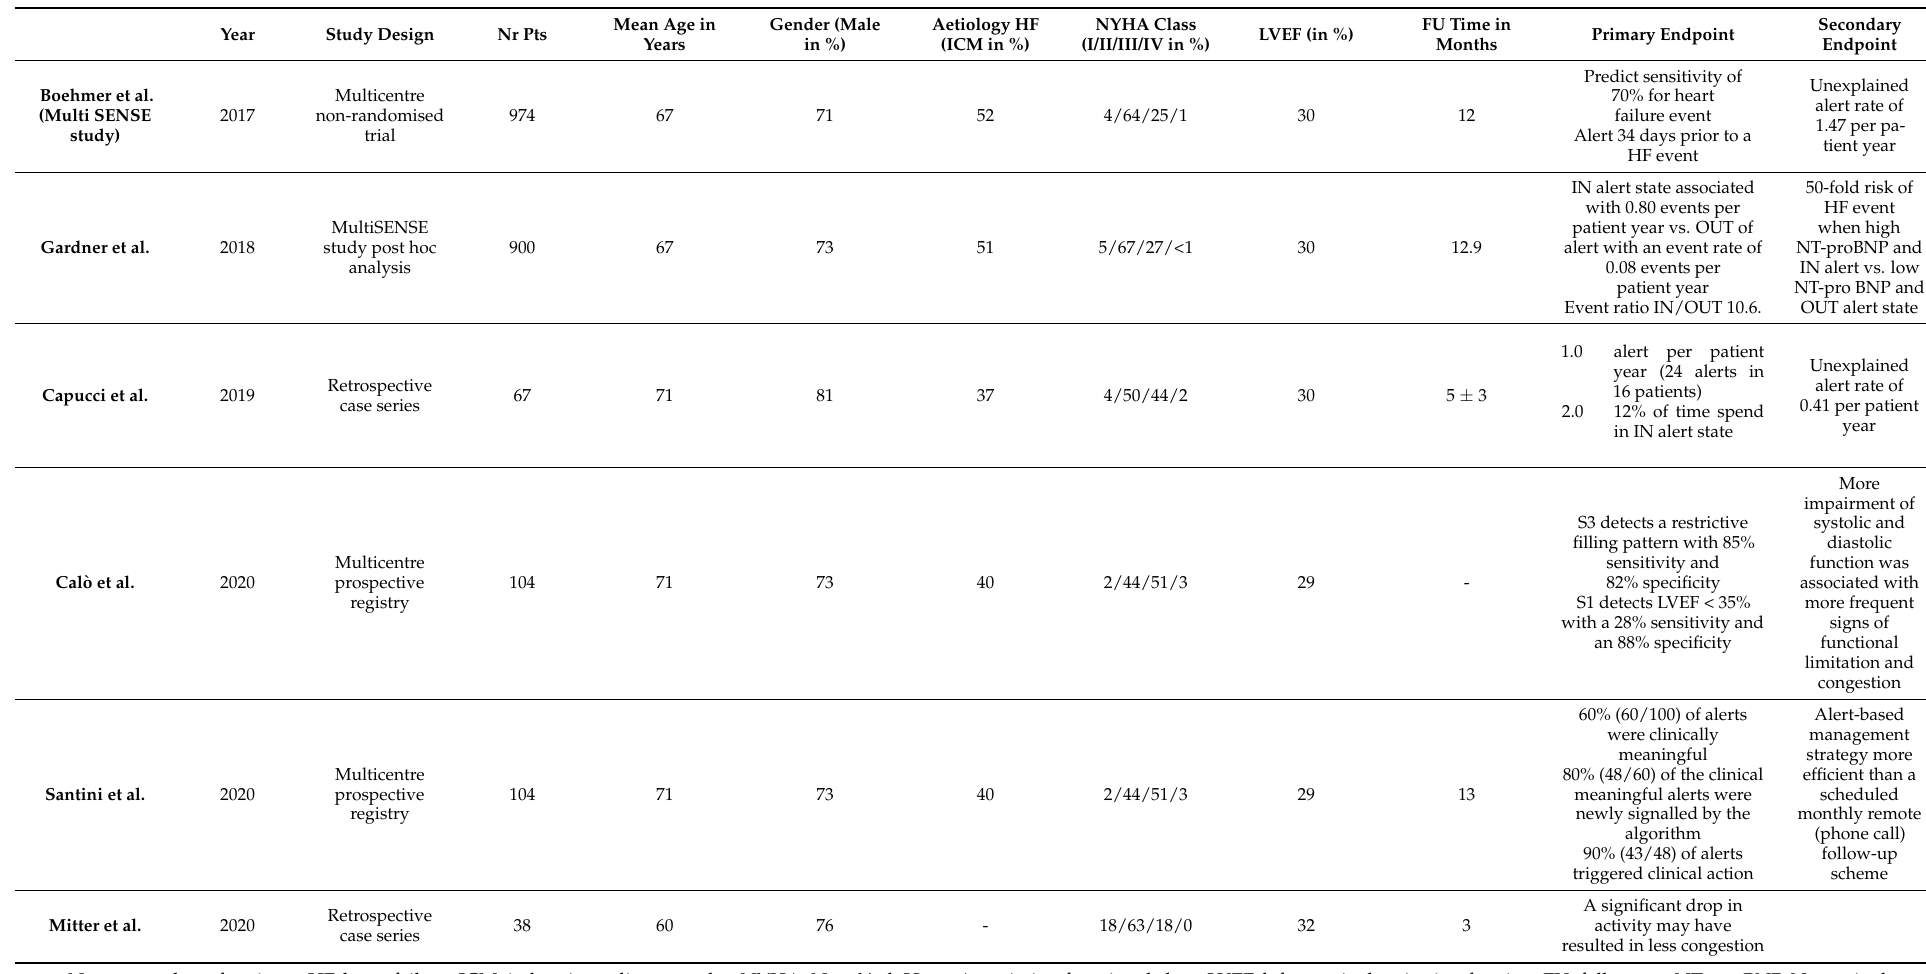
Table 1. Overview of the study characteristics of the 6 publications that fulfilled the literature search and selection